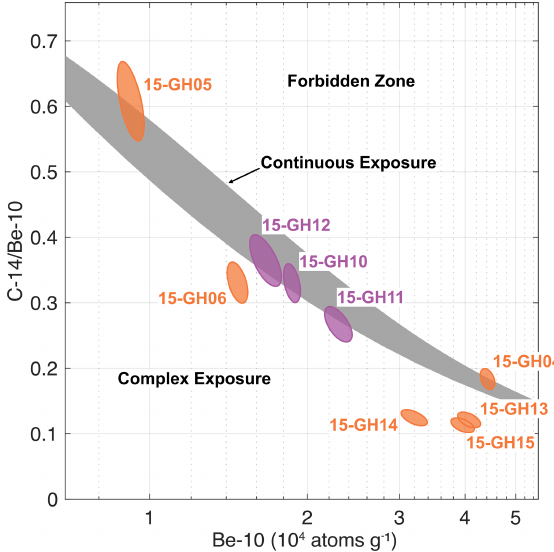
Figure 6. Paired 14 C / 10 Be plot demonstrating that two outer moraine samples, GH05 and GH04, are consistent with a single- stage continuous exposure history with little or no surface erosion (upper bound of gray shaded region); the three inner moraines sam- ples are consistent with continuous exposure but also could be af- fected by a multi-stage exposure history with 10 Be inheritance; and finally four samples from the outer moraines are consistent with complex multi-stage exposure history. Note that 10 Be inheritance serves to lower the 14 C / 10 Be ratio and shift samples to the right. Outer (inner) moraine samples are shown in orange